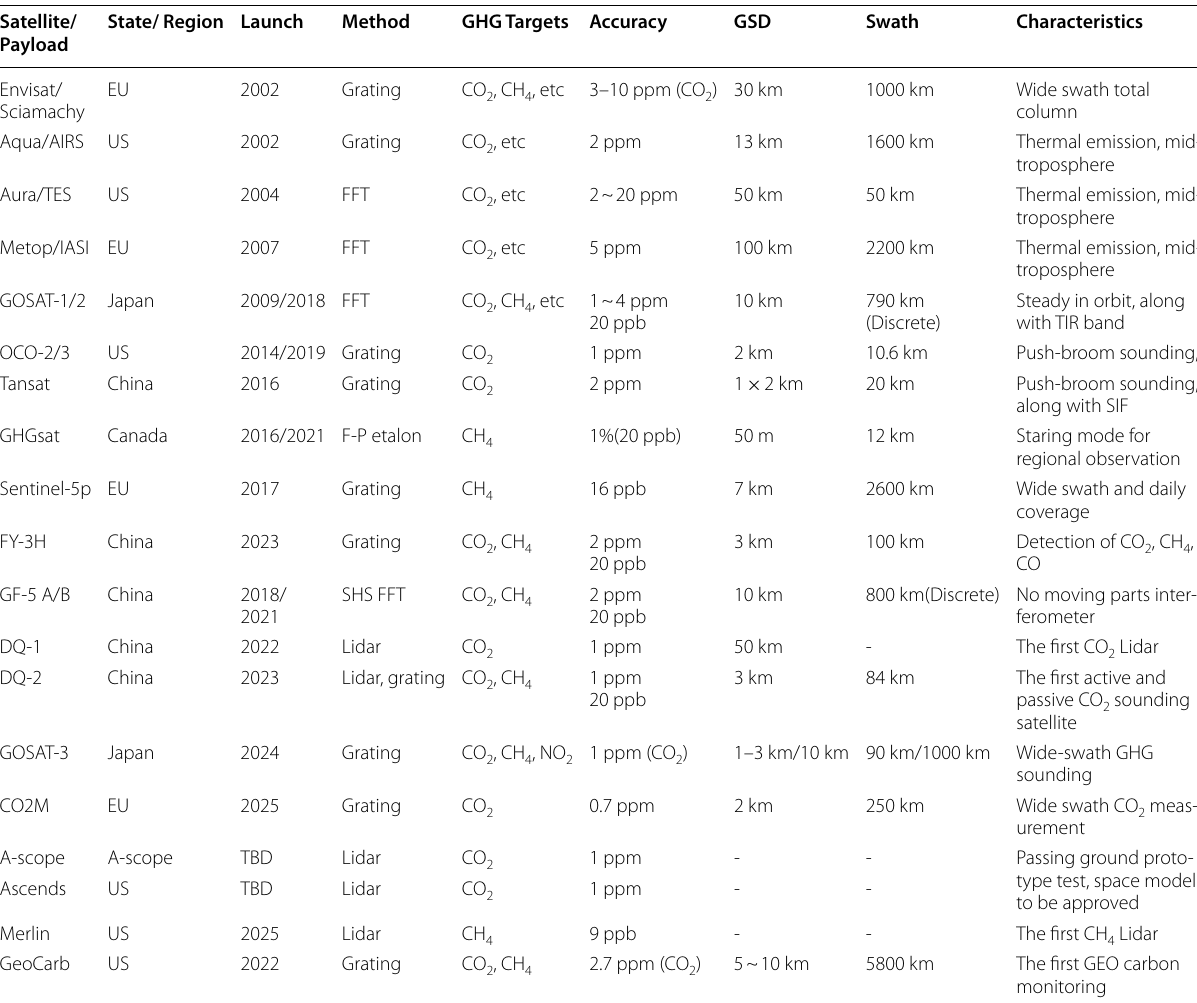
Table 3 Major specification of international carbon monitoring satellite Satellite/